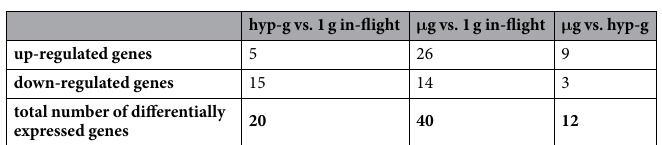
Table 3. Differentially expressed annotated genes in T cells during the 23 rd Parabolic Flight Campaign. Number of annotated significantly differentially expressed genes in the respective comparison after elimination of differentially expressed genes due to hardware effects (hardware 1 g ground control compared to the cell culture control) and 1 g in-flight effects (1 g in-flight control compared to the hardware 1 g ground control). hyp-g: hypergravity samples, μ g: microgravity samples. Fold change ± 1.3, p < 0.05.